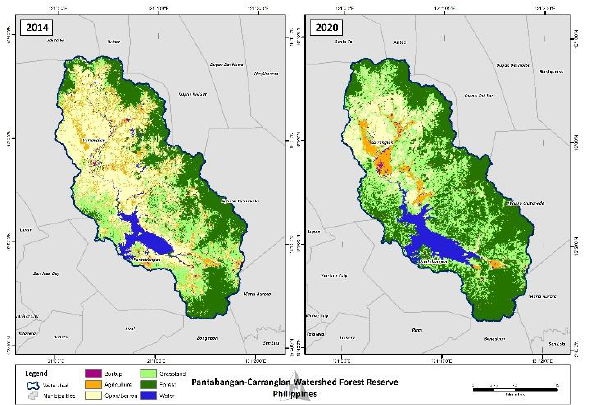
Figure 4. NDMI in Pantangan-Carranglan Watershed based on Landsat 8 for 2014 and 2020.